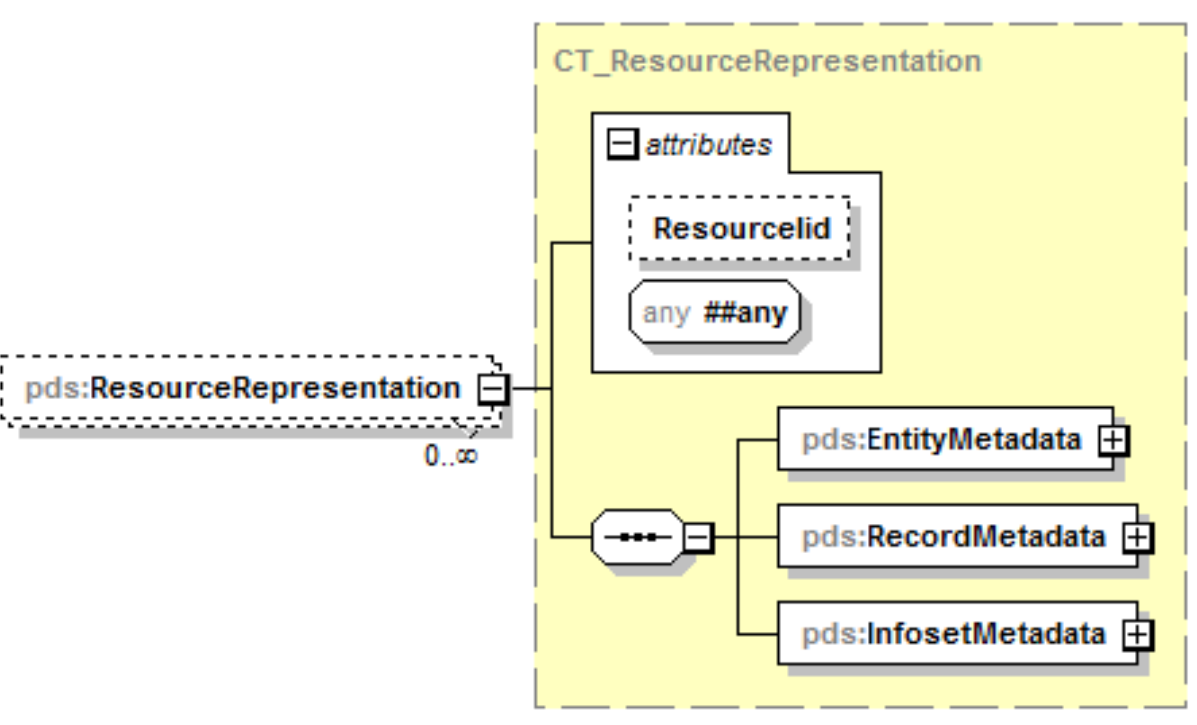
Figure 4. Resource representation: entity metadata is primary or Level 1 metadata about the entity itself, record metadata is secondary or Level 2 metadata about the Level 1 metadata, and infoset metadata is tertiary or Level 3 metadata about the Level 1 and Level 2 metadata; see also Section